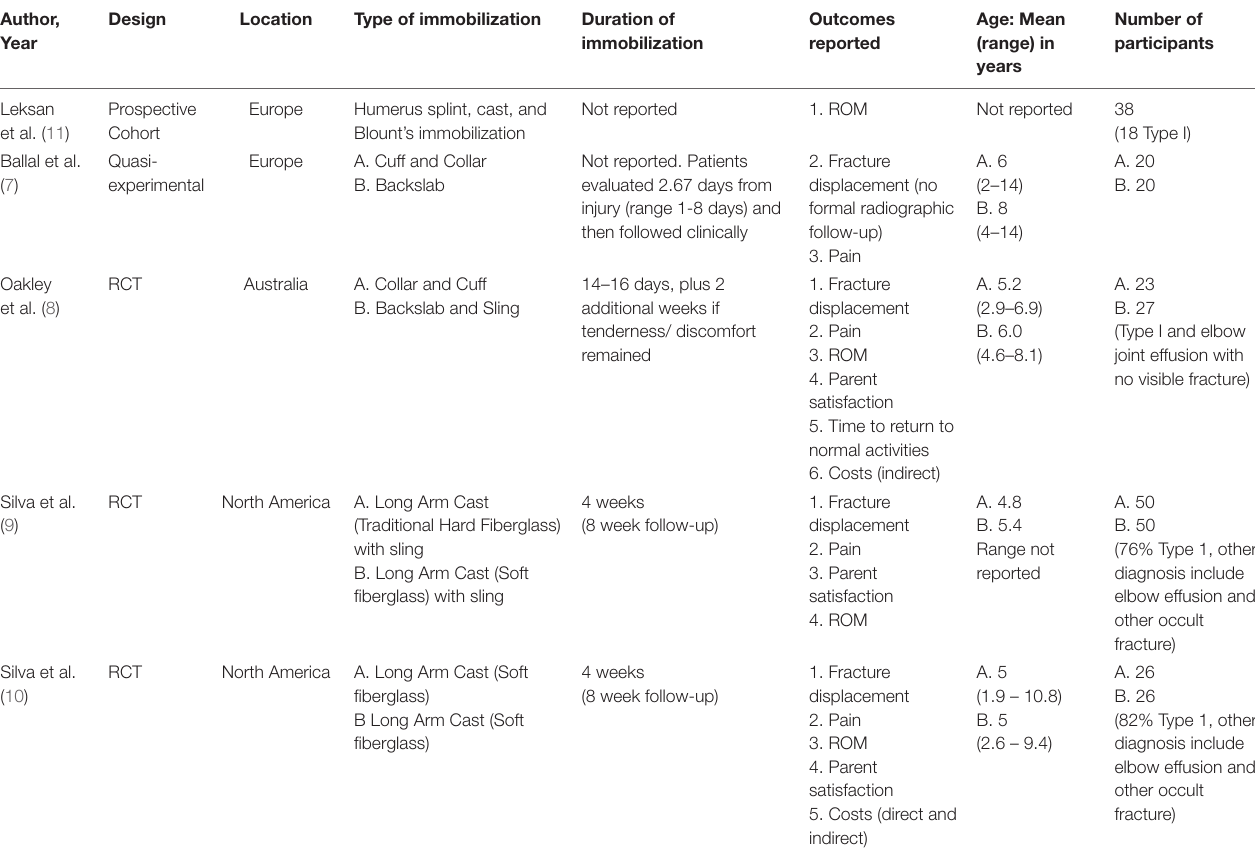
TABLE 1 | Description of studies that met the inclusion criteria and included clinical outcome